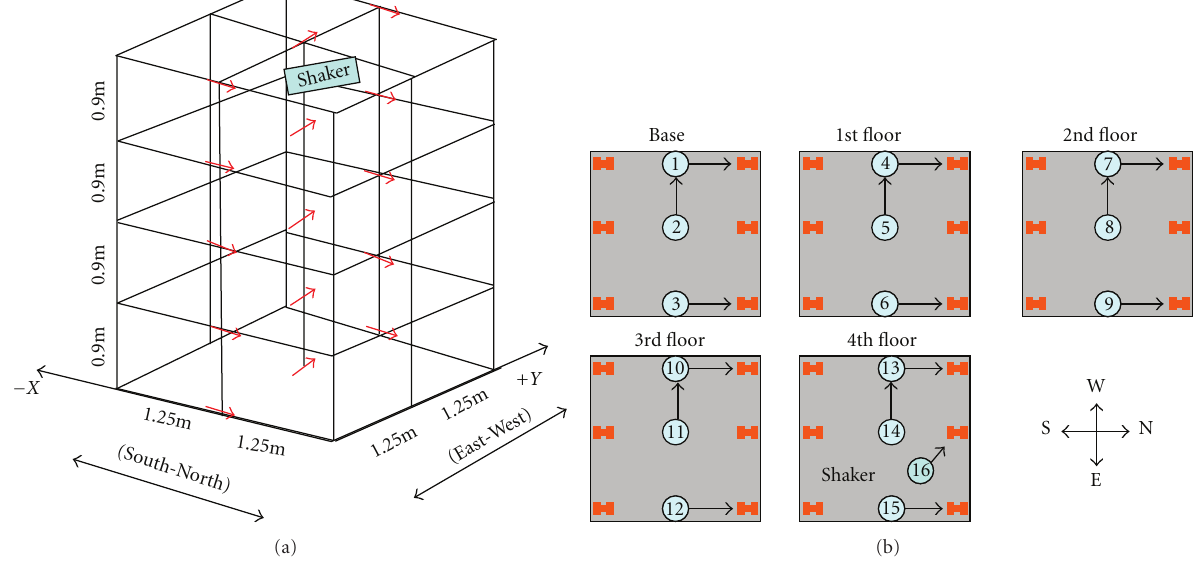
Figure 1: (a) 3D schematic of the ASCE benchmark structure. (b) Location of the accelerometers and shaker on the ASCE benchmark